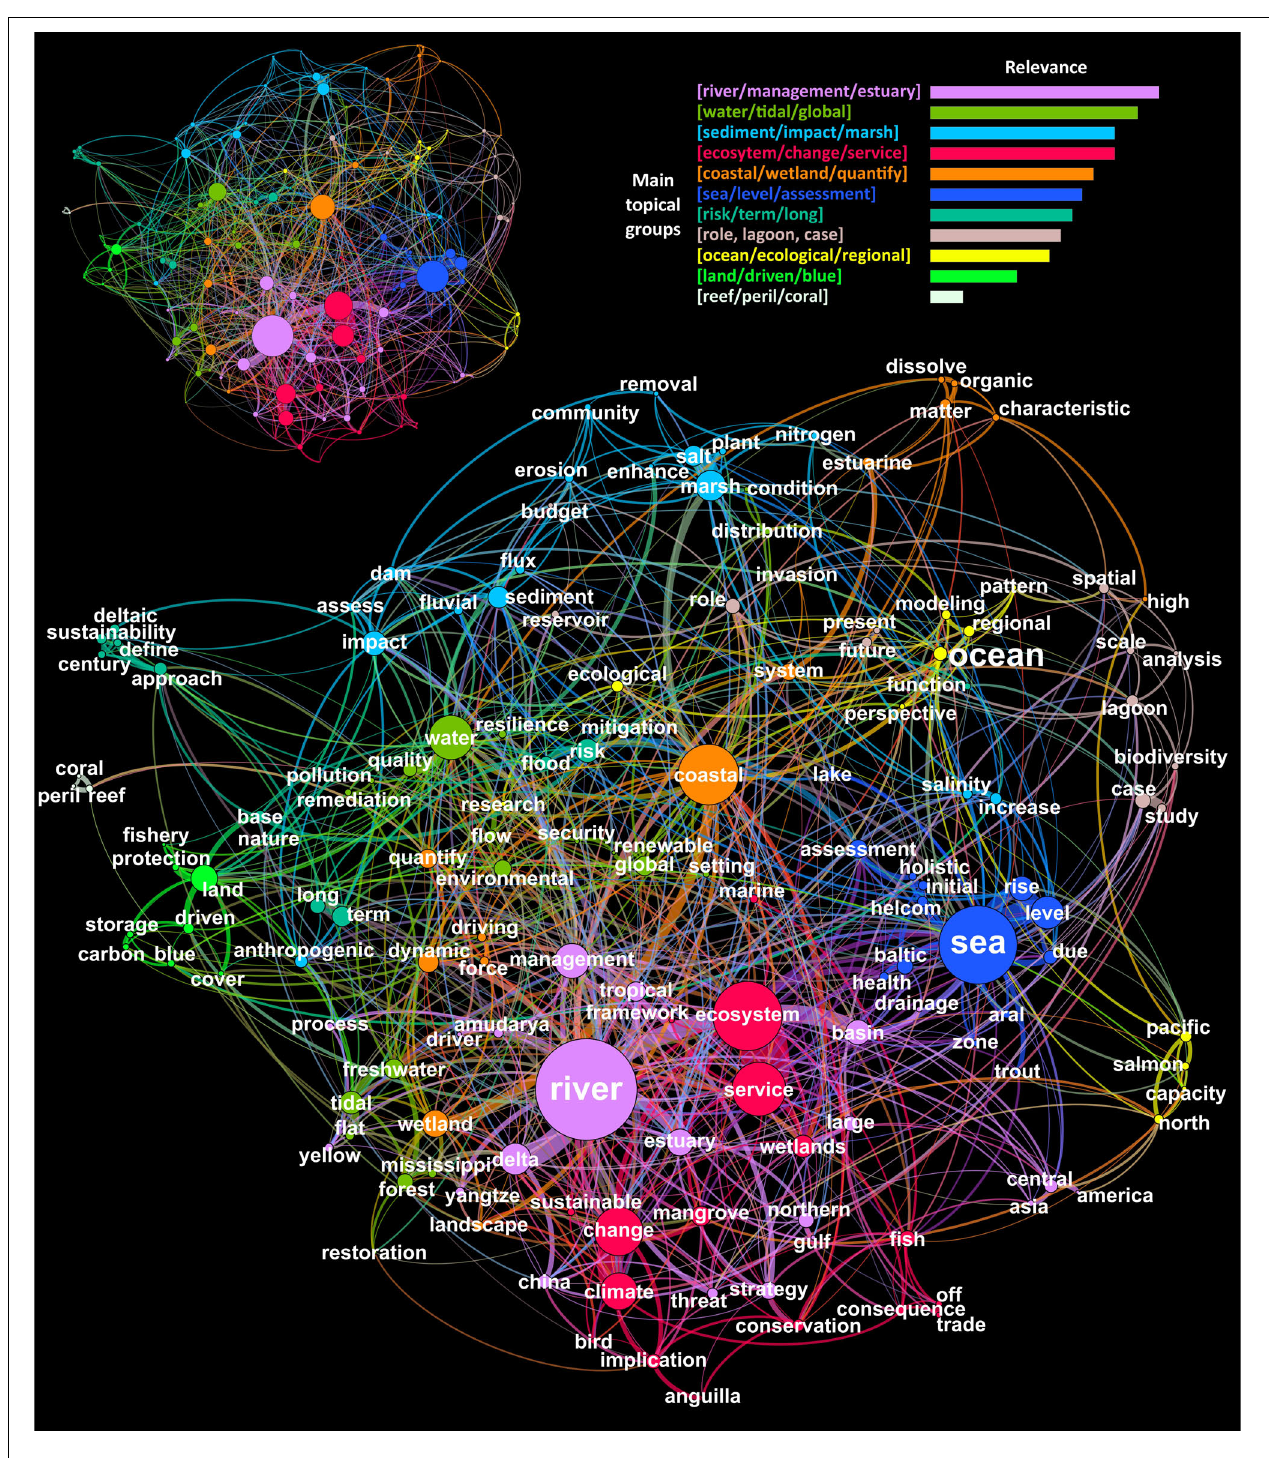
FIGURE 2 | Topical network based on concepts relating with ecosystem services (ES) at the fresh–seawater interface. The network is based on papers including concepts shared between oceans, seas and rivers ( n = 177). In the upper-left graph, the network structure is shown, with nodes being words/topics, edges between nodes representing the association of nodes in the text, and edge-weights being proportional to the frequency of these associations across the analysed dataset. Nodes’ size is proportional to their importance in the network. Nodes’ colour remarks their belonging to different topical groups, shown in the upper-right bars’ drawing. The larger graph shows the topical network with labels indicating ES-related